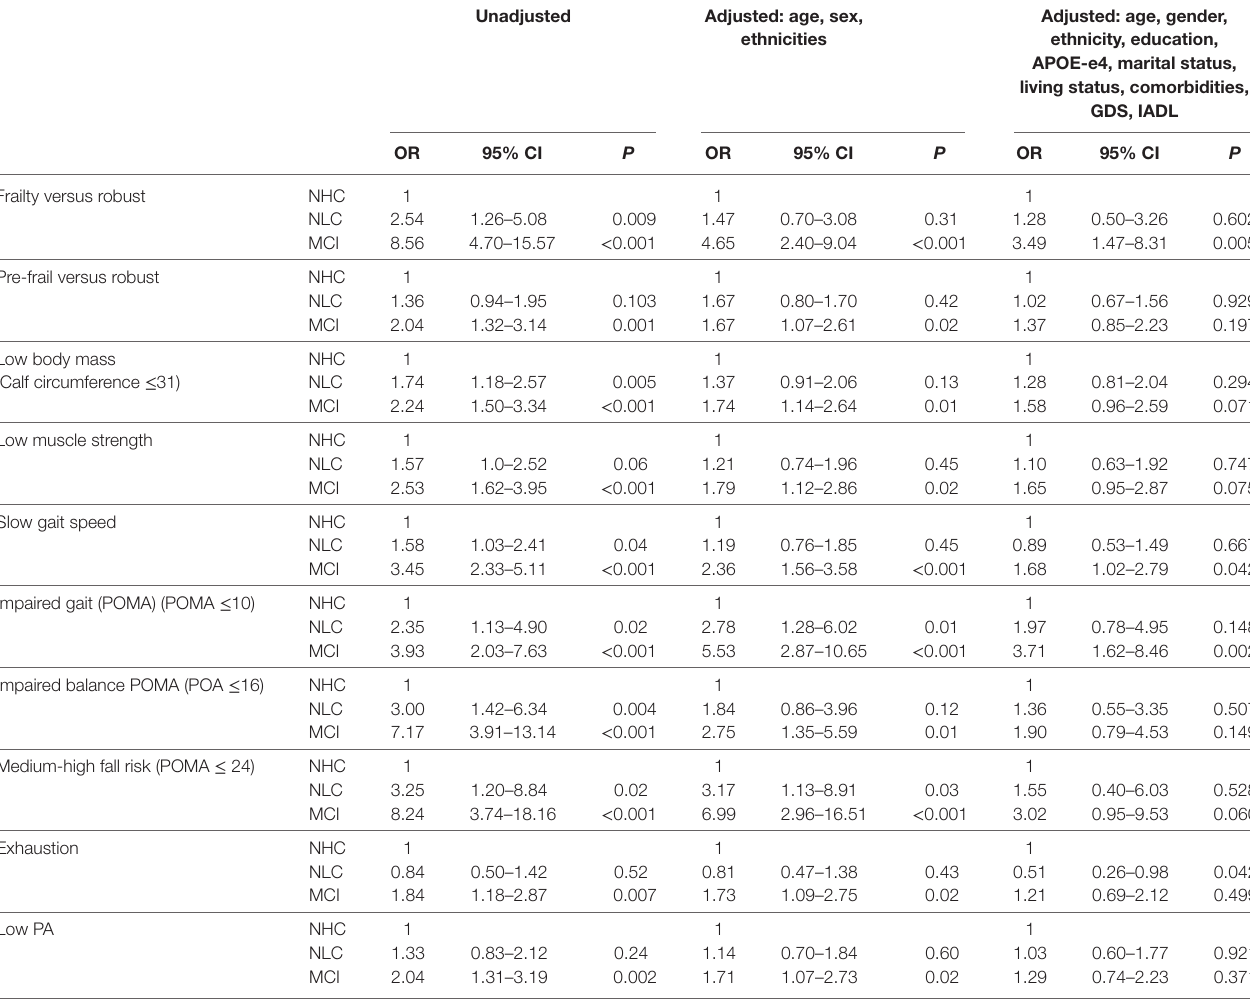
Table 3 | Odds ratio of association of physical frailty status and components with cognitive status [mild cognitive impairment (MCI), normal low cognition (NLC), normal high cognition (NHC)].